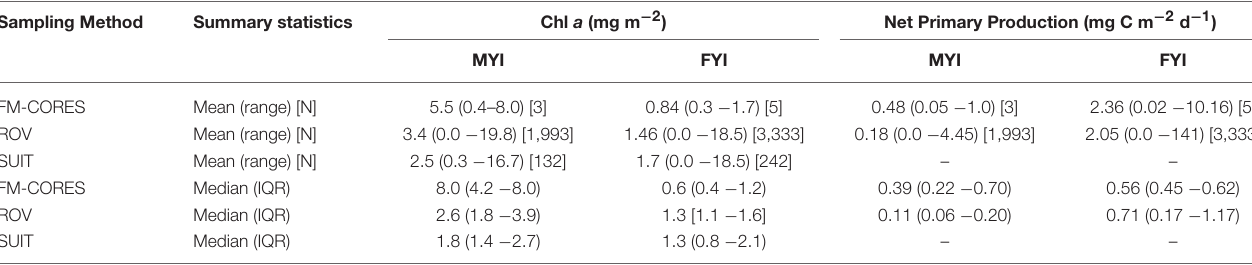
TABLE 2 | Ice algal chlorophyll a biomass and NPP summarized for sampling gears into MYI and FYI. Means, range (min–max), and sample size [N] are provided for comparison to values presented in Fernández-Méndez et al. (2015). Sampling